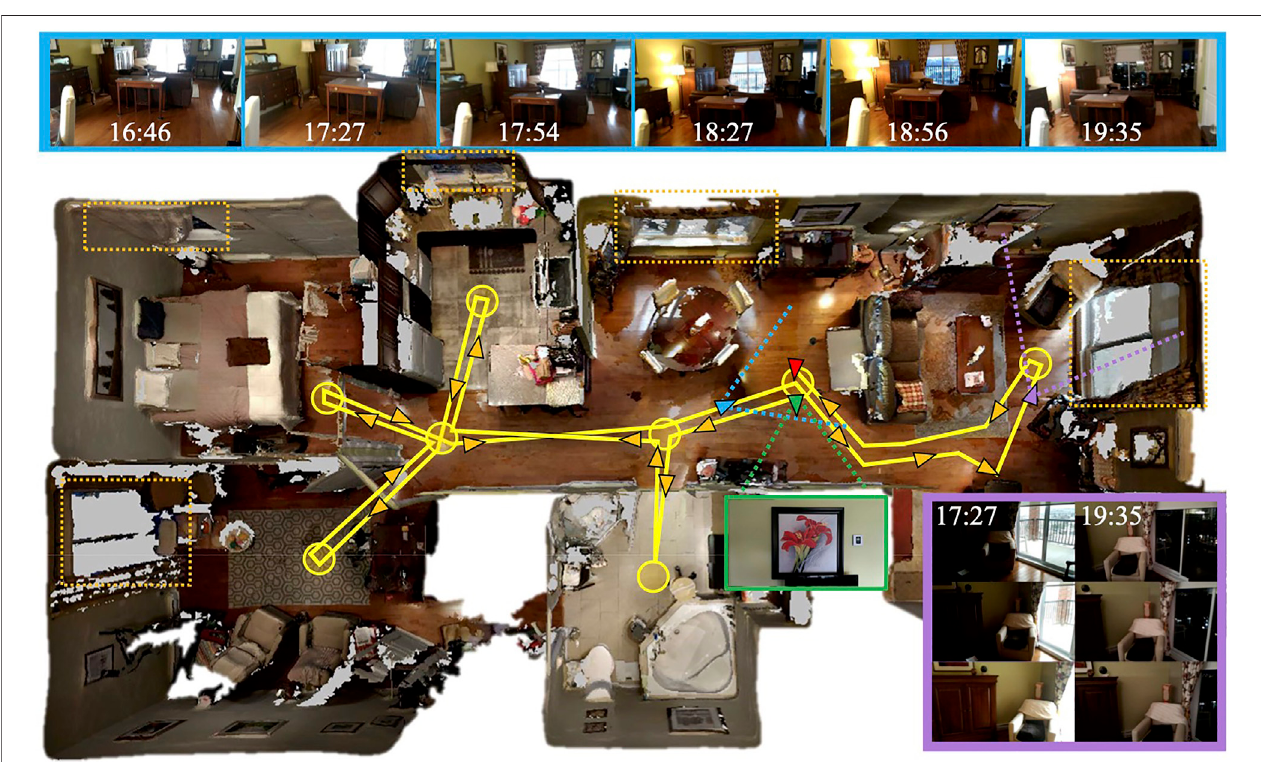
FIGURE 3 | Top view of the testing environment with the followed trajectory in yellow. Start and end positions correspond to green and red triangles respectively, whichareboth oriented towardthesame pictureonthewallshown inthegreenframe.Thecirclesrepresent waypoints wherethecamera rotatedinplace. Windowsare located in the dotted orange rectangles. The top blue boxes arepictures taken from asimilarpoint ofview (located by the blue triangle) during the six mapping sessions. The purple box shows three consecutive frames from two different sessions taken at the same position (purple triangle), illustrating the effect of autoexposure.